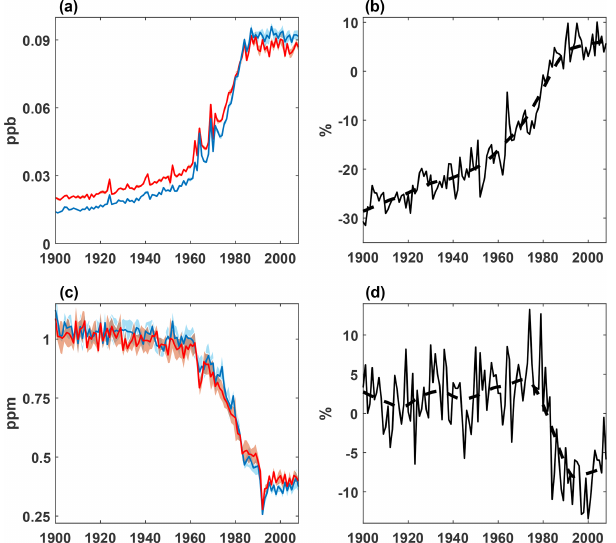
Figure 10. (a) July–September ensemble mean time series of polar ClO (70–90 ◦ S, 100hPa) in EXP (blue) and REF (red). The shaded light blue and red areas represent 95% confidence intervals of en- semble means. (b) Relative difference of ClO EXP and REF (solid line) and 31-year smooth trend (dotted line). (c) August–October ensemble mean time series of polar O 3 (70–90 ◦ S, 100hPa) in EXP (blue) and REF (red). Shaded light blue and red areas represent 95% confidence intervals of ensemble means. (d) The relative dif- ference of O 3 EXP and REF (solid line) and 31-year smooth trend (dotted line).